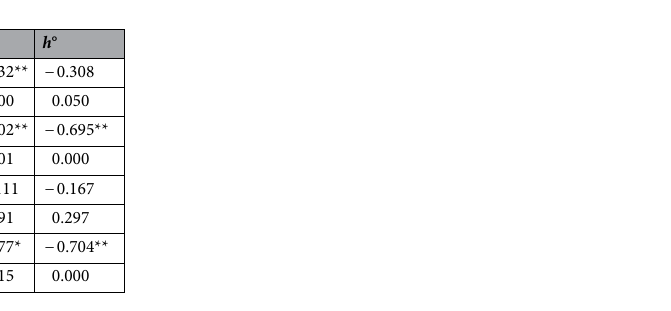
Table 2. Results of bivariate correlation analysis. *At level 0.01 (double tail), the correlation was significant. *At level 0.05 (double tail), the correlation was